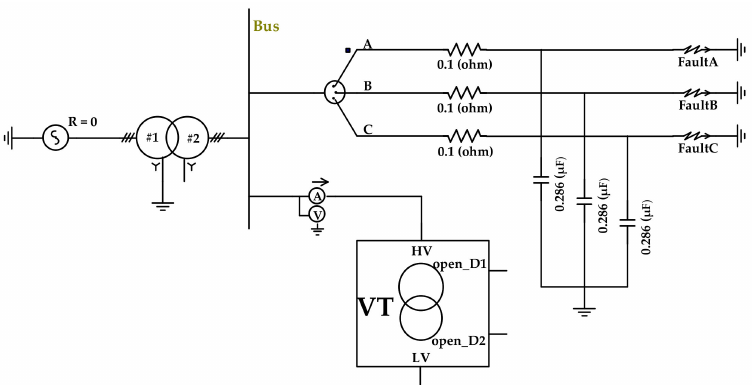
Figure 4. Ferroresonance current simulation of 35 kV VT. HV: high voltage input; LV: low voltage output.